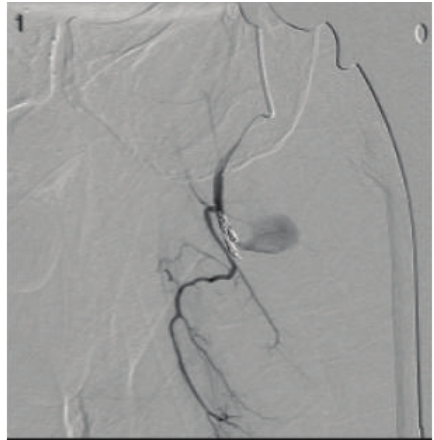
Figure 8: Imaging of embolization of the pseudoaneurysm by coiling and Gelfoam, performed by IR.